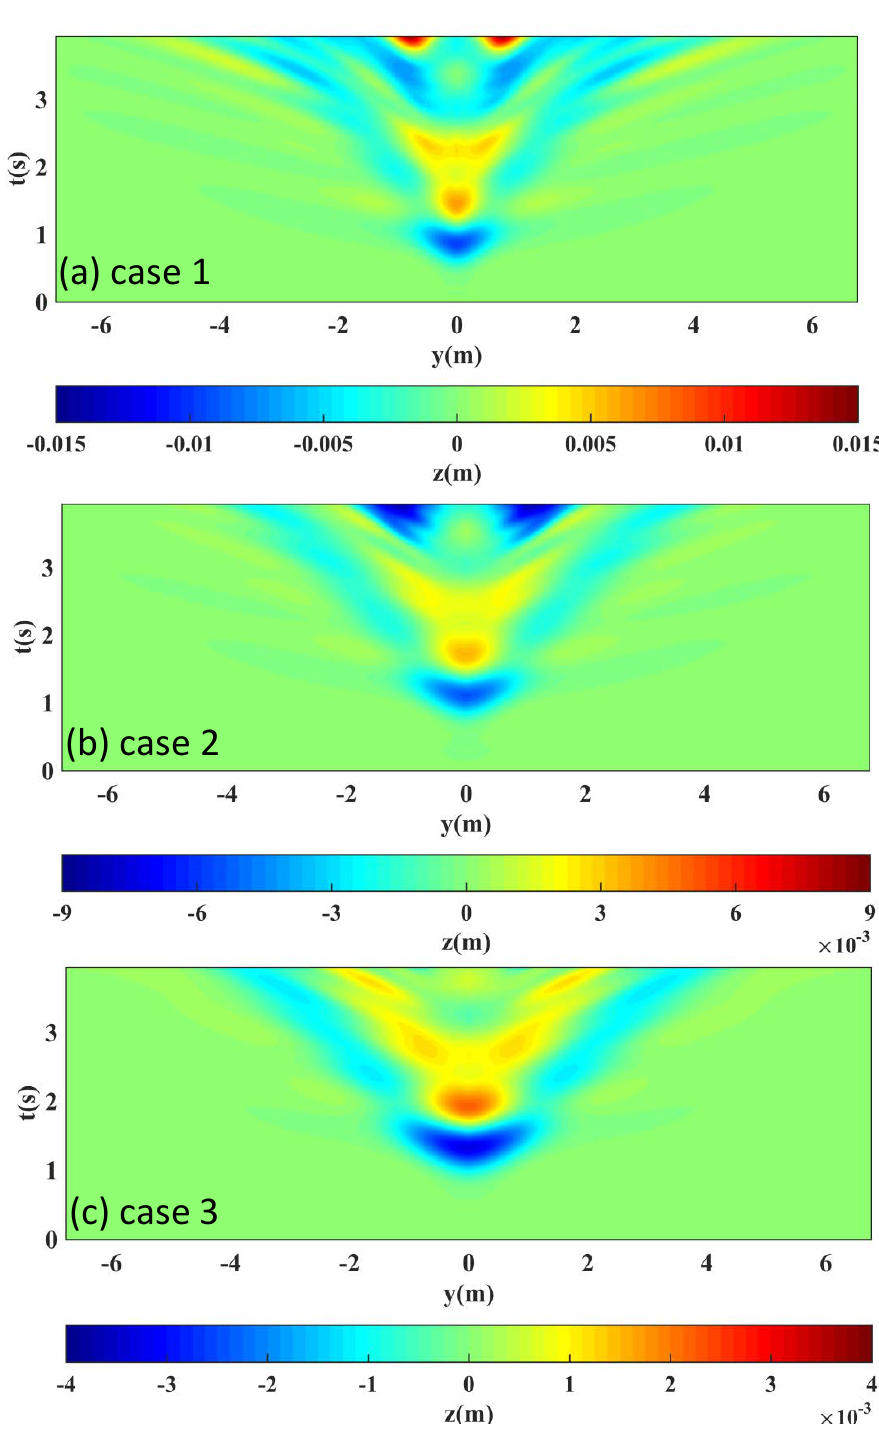
Figure 16. Time series of the run-up heights along the shore. ( a ): case 1; ( b ): case 2; ( c ): case 3.